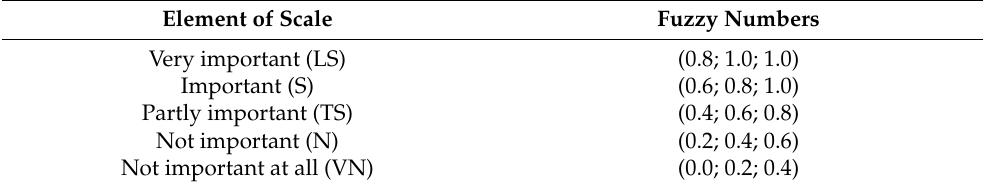
Table 2. The conversion of the linguistic scale into uncertain numbers.